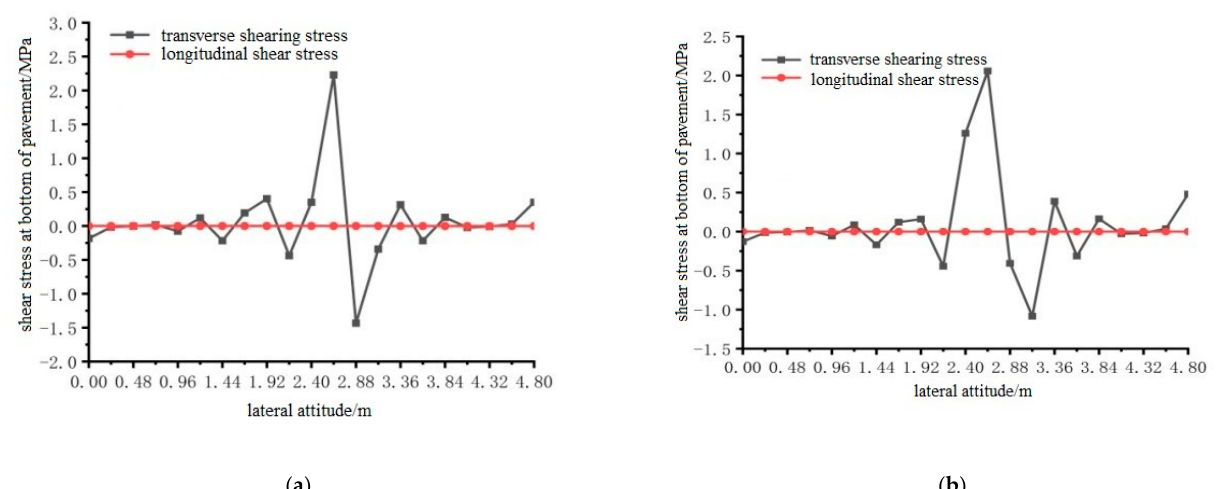
Figure 30. The transverse distribution of longitudinal and transverse shear stress on the bottom surface of the pavement with and without temperature field under the action of load level 1. ( a ) Longitudinal and transverse shear stress diagrams without temperature field; ( b ) Longitudinal and transverse shear stress diagrams with temperature field effect.